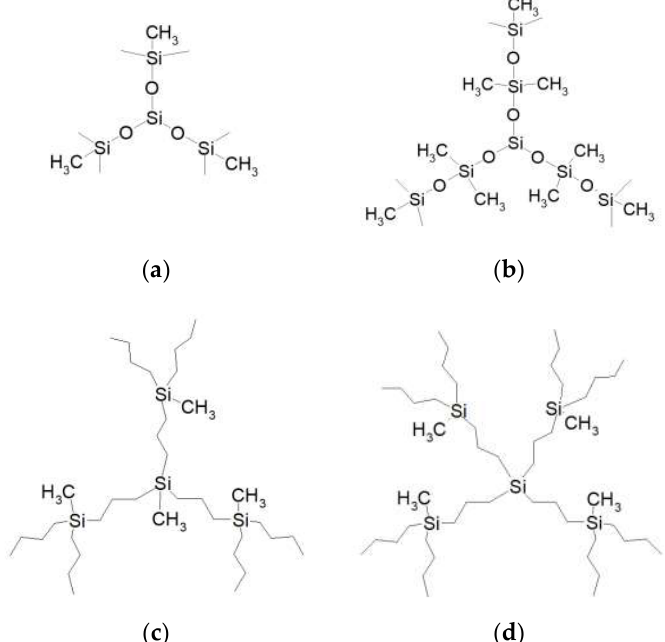
Figure 1. The structure of the first generations of the dendrimers under study. ( a ) siloxane dendrimers with shorter spacers (s-dendrimers), ( b ) siloxane dendrimers with longer spacers (l-dendrimers), ( c ) polybutylcarbosilane dendrimers with three-functional Si core atoms (c3-dendrimers) and ( d ) polybutylcarbosilane dendrimers with tetrafunctional Si core atoms (c4-dendrimers).